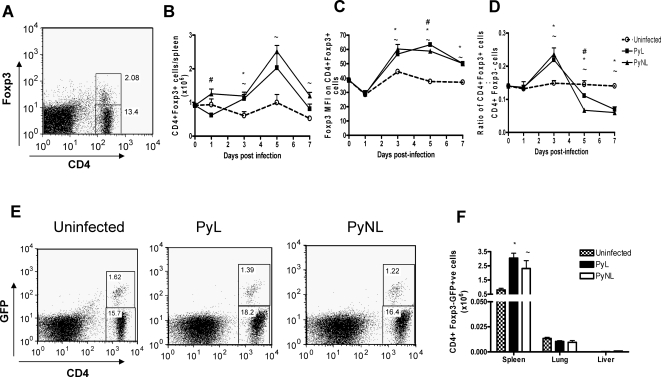
Expansion and activation of natural Foxp3+ regulatory T cell populations during PyL and PyNL infections.Numbers and activation status of Foxp3+ regulatory T cells were determined on various days post-infection with PyL or PyNL in (A–D) WT mice or (E–F) Foxp3-GFP transgenic mice. (A) Representative dot plot of intracellular staining in CD4+ T cells. On selected days post-infection with PyL or PYNL, splenic CD4+ lymphocytes were analysed for (B) numbers of Foxp3+ cells,(C) intensity (MFI) of Foxp3 staining and (D) ratio of Foxp3+ to Foxp3− cells. (E) Representative dot plots showing GFP (Foxp3) expression in CD4+ splenocytes from 7 day PyL and PyNL-infected animals and uninfected controls. (F) Numbers of splenic GFP+ (Foxp3+) CD4+ regulatory T cells on day 5 post infection. 3–5 mice per group. Results are representative of 3 independent experiments. Symbols represent significant differences (p<0.05) between groups: # PyL vs PyNL; * PyL vs uninfected; ∼ PyNL vs uninfected.